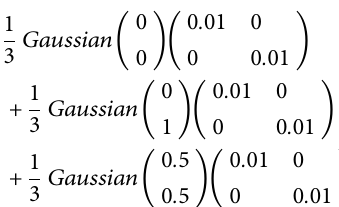
Frontiers in Arti fi cial Intelligence |